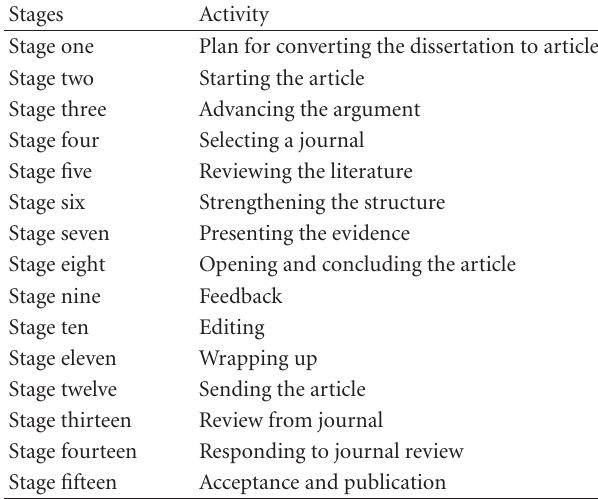
Table 8: Dissertation to